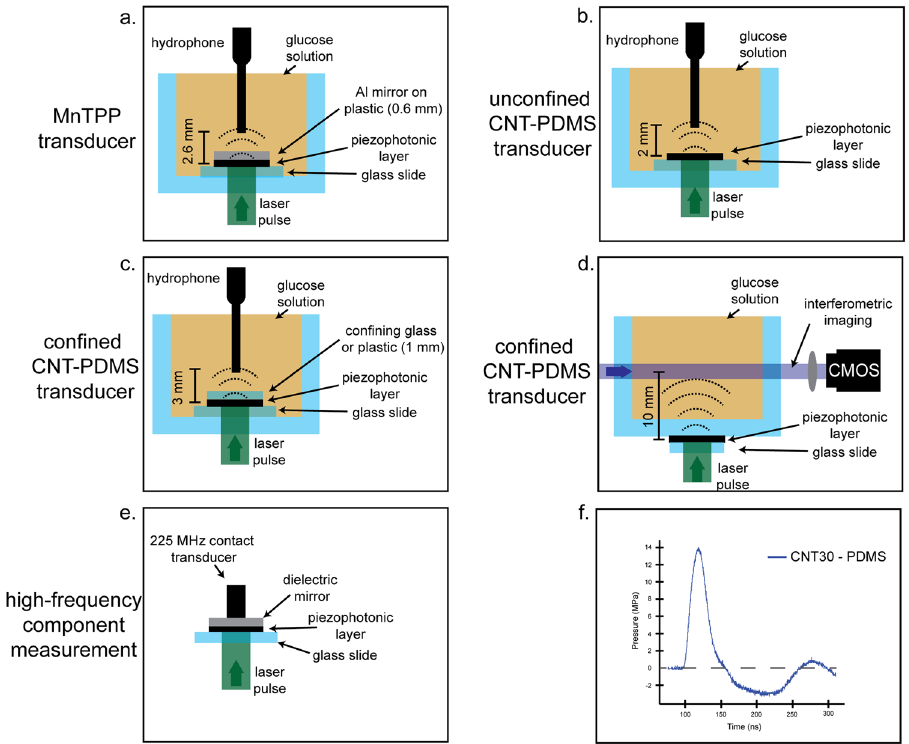
Figure 1. Configurations employed to measure absolute pressures with hydrophone and frequency distributions with contact transducer. ( a ) MnTPP deposited on a glass slide and confined with an aluminium mirrored plastic cover. ( b ) CNTs grown on a glass slide and infused with PDMS. ( c ) Similar CNTs infused with PDMS but now covered with either a plastic cover or a glass slide. (These samples are referred to